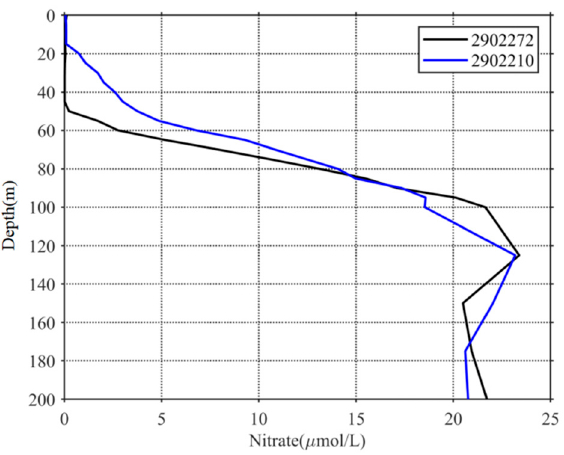
Figure 8. Vertical distribution of nitrates in October based on WOA 18 datasets.